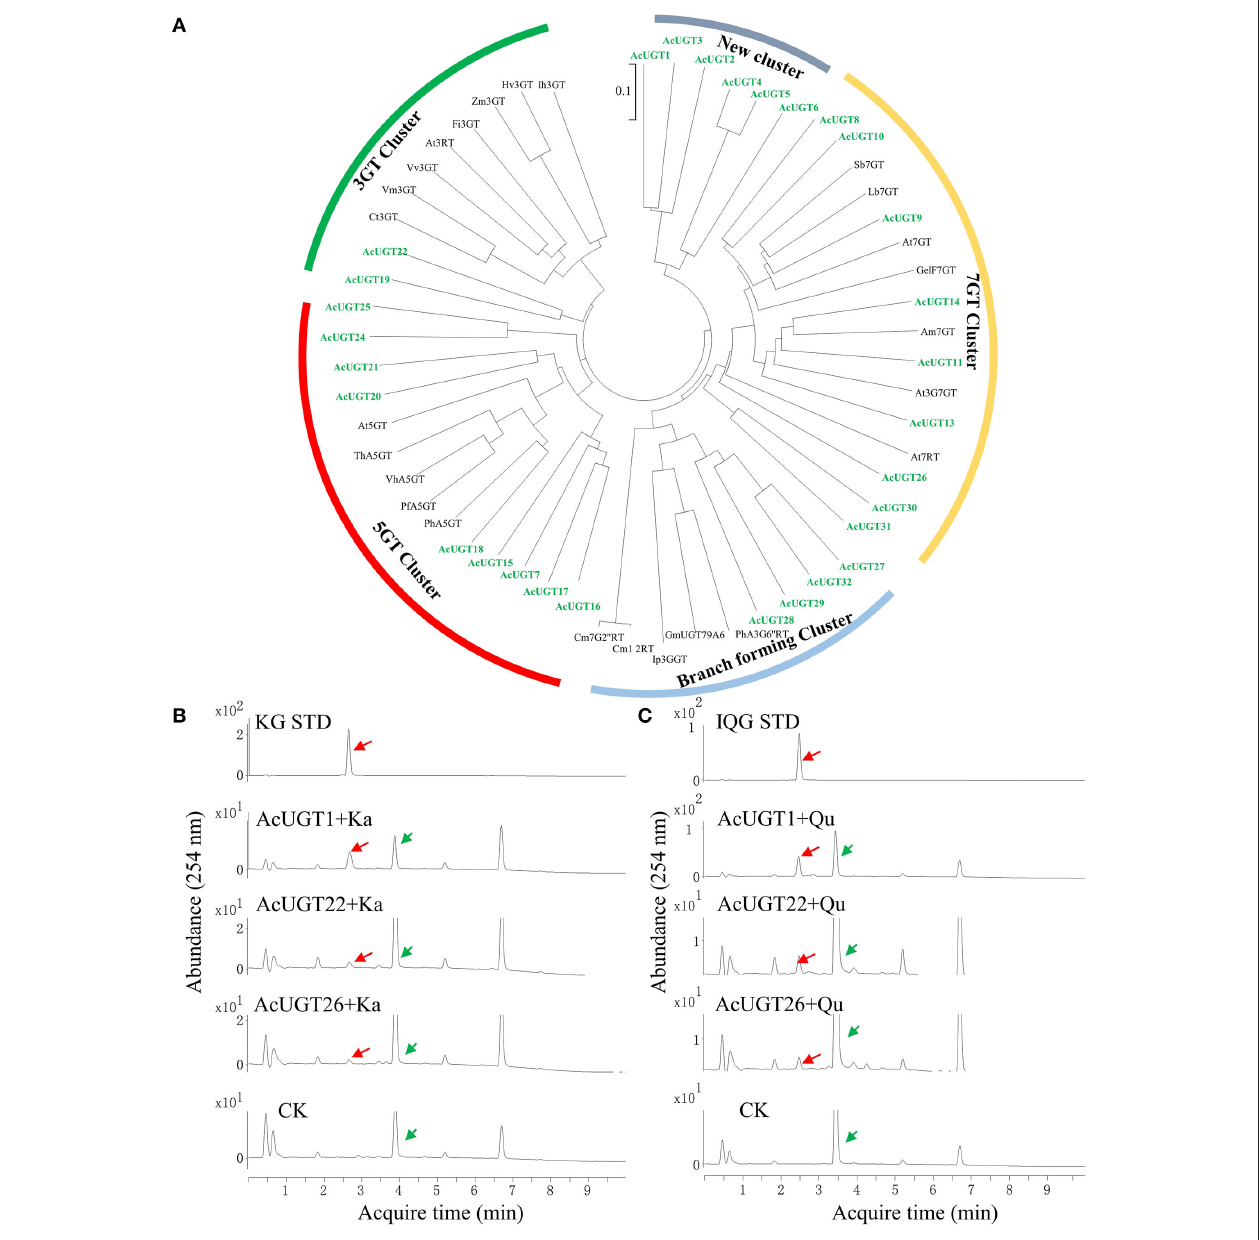
FIGURE 4 | A phylogenetic tree and enzymatic analysis to screen for flavonol glucosyltransferases. (A) A phylogenetic tree of 30 AcUGTs and reported UGTs, sequence of reported UGTs were from Yin et al. (2021). (B) The UPLC spectra of AcUGT recombinant proteins with UDPG and kaempferol (Ka). (C) The UPLC spectra of AcUGT recombinant proteins with UDPG and quercetin (Qu). The green arrows indicate substrates, while the red arrows indicate products. KG STD, astragalin standard; IQG STD, isoquercitrin standard. CK means control, the enzymatic activity of the boiled protein encoded by empty-vector, substrates and UDP-glucose.